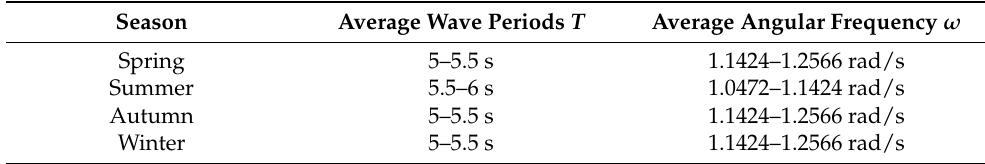
Table 3. The average wave periods and frequencies in Yellow Sea near Lianyungang